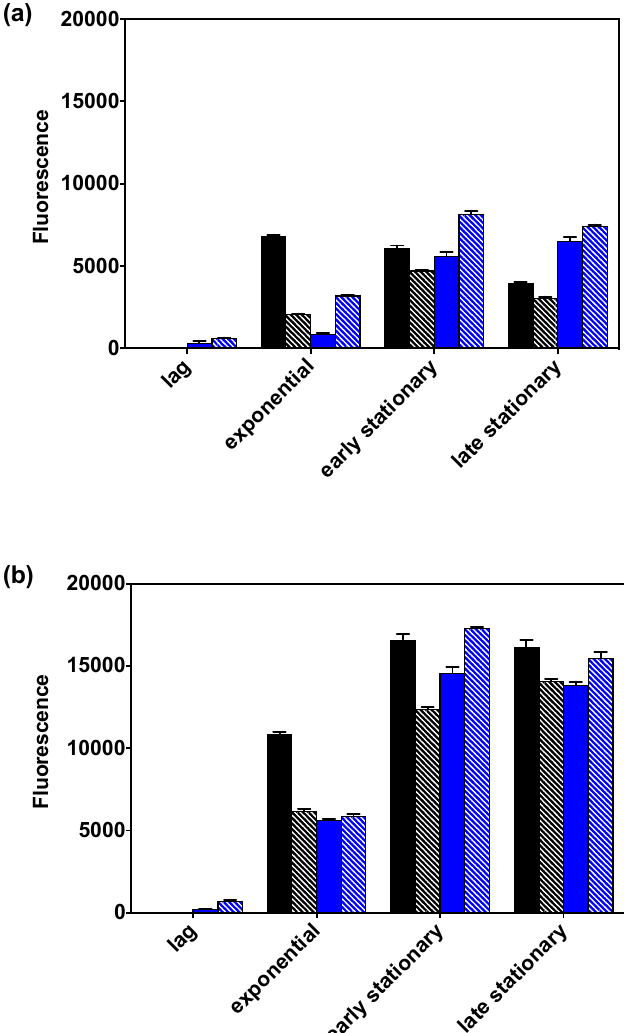
Figure 5. Polyhydroxybutyrate (PHB) production surveyed using the Nile red fluorescence assay for C. necator H16 (black solid bars) and v6C6 variant (blue solid bars) in 0.59% ( w / v ) gluconate and C. necator H16 (black stripe bars) and v6C6 variant (blue stripe bars) in 0.50% ( w / v ) glycerol. Cells were cultivated either in nutrient-balanced ( a ) or nitrogen-limiting ( b ) MSM.